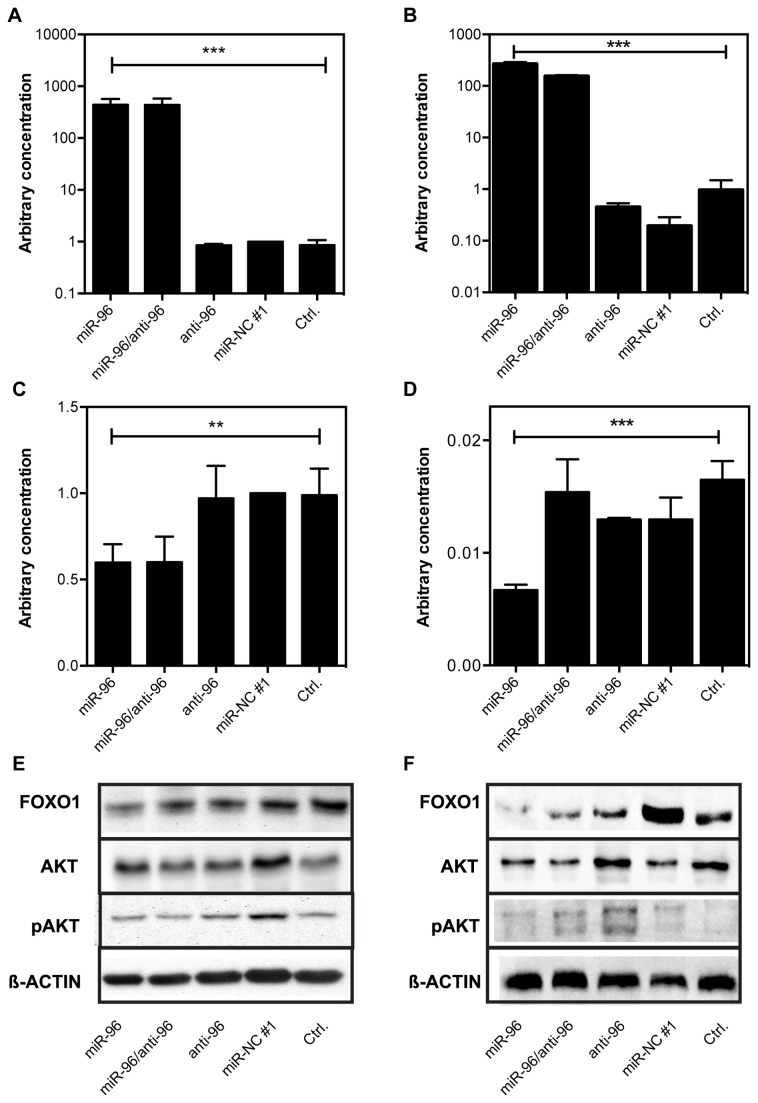
Effect of miR-96 overexpression on FOXO1 expression.Prostate cancer cells were transfected with 10 nM pre-miR-96, anti-miR-96, pre-miR-NC #1 or combination of pre-miR-96 and anti-miR-96. miR-96 expression in (A) LNCaP and (B) DU145 cells and FOXO1 expression in (C) LNCaP and (D) DU145 cells. Data are shown as mean (+SD) of three independent assays. ** P <0.01, *** P <0.001, One-way ANOVA. FOXO1, AKT, and pAKT protein expression in (E) LNCaP and (F) DU145 cells was visualized by western blotting. β-Actin was used as a loading control.